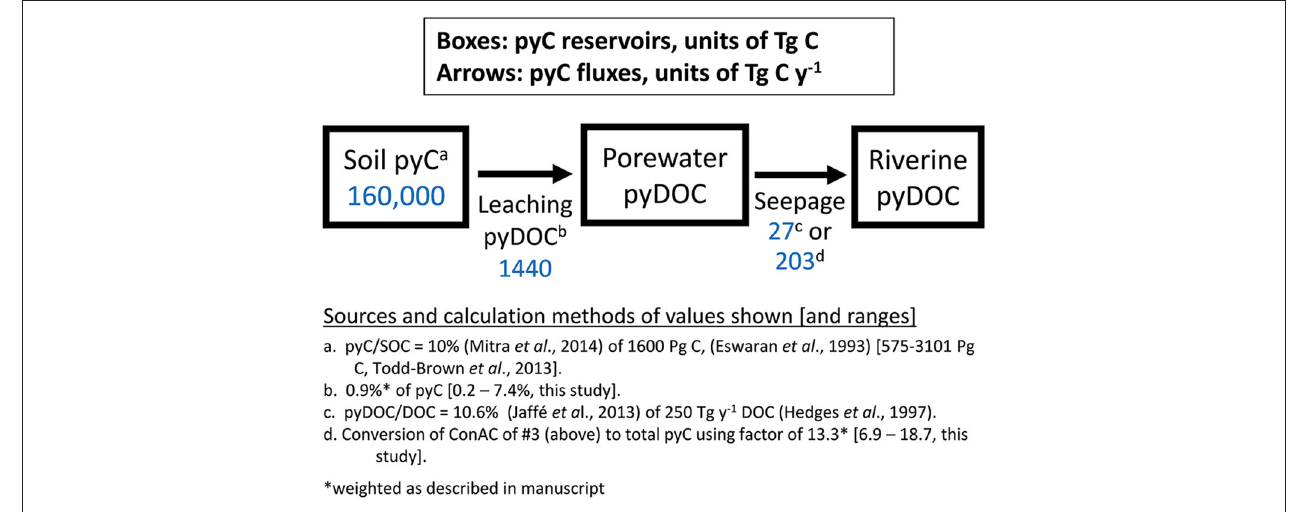
FIGURE 8 | Box model of pyC transfer from terrestrial to fluvial